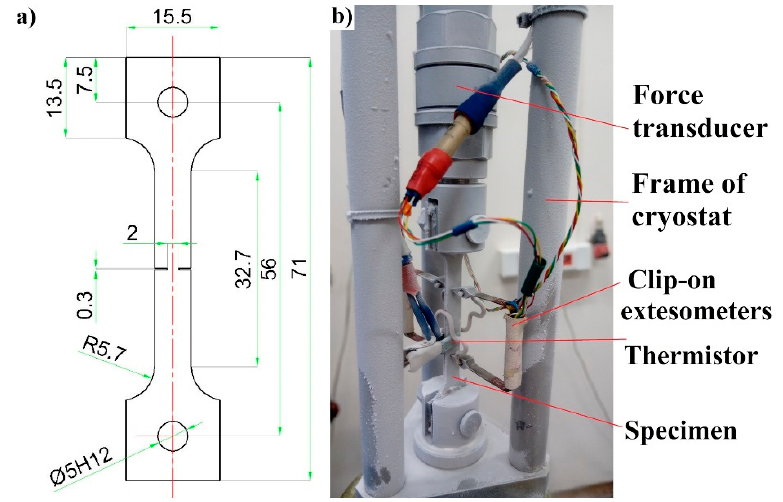
Figure 2. ( a ) Specimen geometry (thickness of 2 mm); ( b ) the cryostat arrangement- specimen with transducers ready for the test at 4.2 K. Table 1. Chemical composition of 316L specimens.